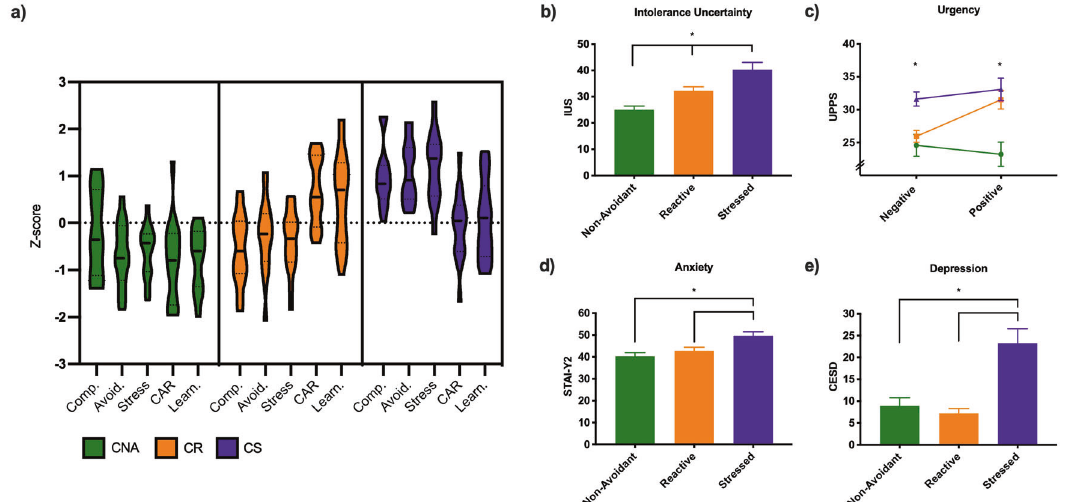
Fig. 1 Subtype characteristics on cluster variables and internal validation measures. a Violin plots for each of the cluster variables by subtype and comparison of subtype differences on b intolerance of uncertainty c positive and negative d anxiety and e depression. CNA (green) Compulsive Non-Avoidant; CR (orange) Compulsive Reactive; CS (purple) Compulsive Stressed subtype. Comp. = Y-BOCS z-score for primary compulsion; Avoid. = MEAQ behavioral avoidance z -score; Stress = PSS z-score; CAR = cortisol awakening response salience z-score; Learn. = valence learning bias z-score as measured by the BeanFest task. IUS Intolerance of Uncertainty Scale, UPPS = UPPS-P impulsive behavior scale. STAI-Y2 State-Trait Anxiety Inventory Y2 (trait); CESD Centre for Epidemiologic Studies Depression Scale Revised. Bars represent group means and error bars represent standard error. * p <